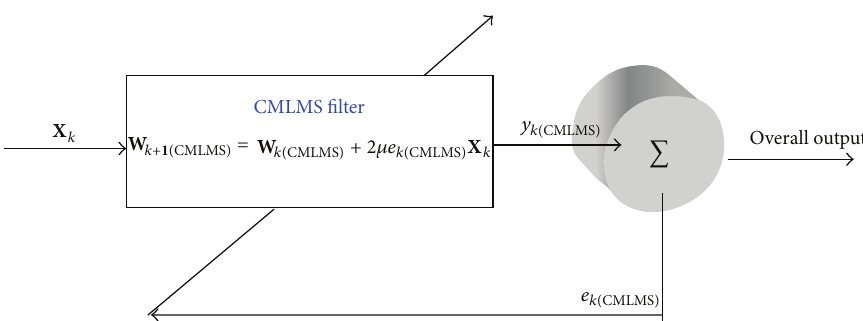
Figure 2: CMLMS adaptive filter